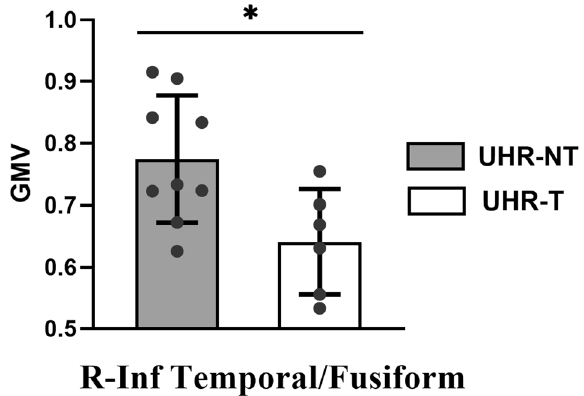
Fig. 3 GMV differences between the UHR-T and UHR-NT sub- groups. UHR-T and UHR-NT: transformed and non-transformed subgroups within the UHR group. Asterisk, * P ≤ 0.05. Inf Temporal, inferior temporal gyrus.